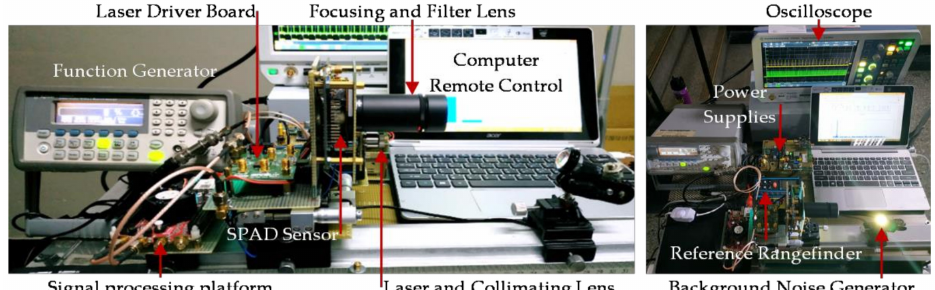
Figure 4. The detailed installation of the LiDAR